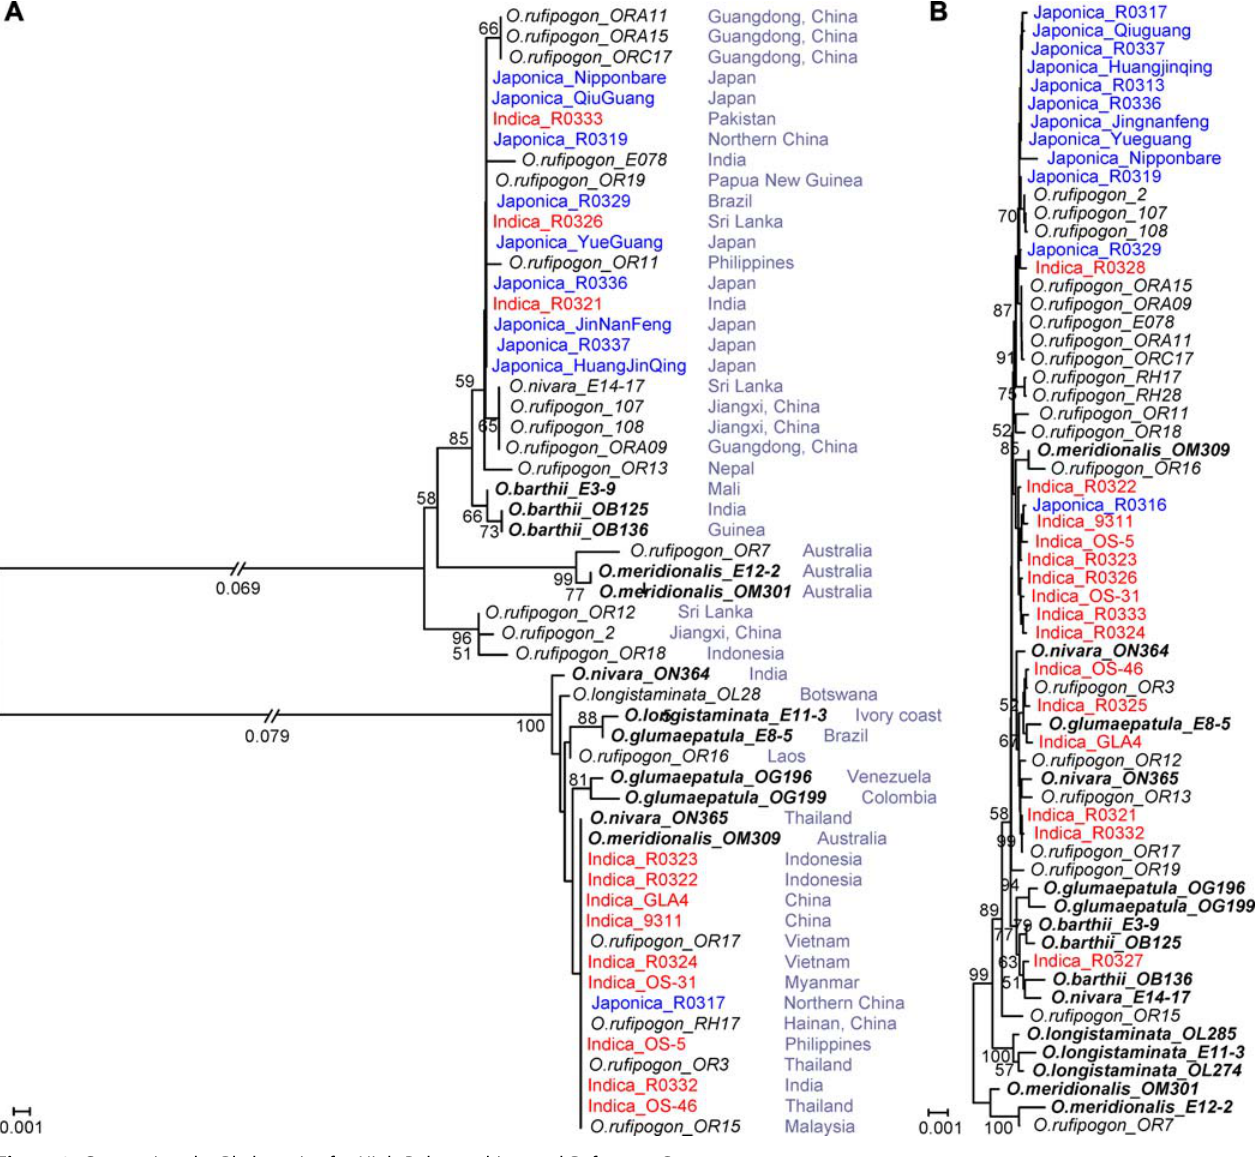
Figure 3. Contrasting the Phylogenies for High Polymorphism and Reference Genes (A) Neighbor-joining tree of a high polymorphism gene AK100970 with the geographical origins of the samples noted. (B) Neighbor-joining tree of the ten reference genes listed in Table S8. The bootstrap values are indicated at nodes with at least 50% support. Cultivars are labeled in blue for japonicas and in red for indicas. O. rufipogon are indicated by italics and other wild species are indicated by boldface. Note that the size of the tree shown in Figure 3A is only half of the actual